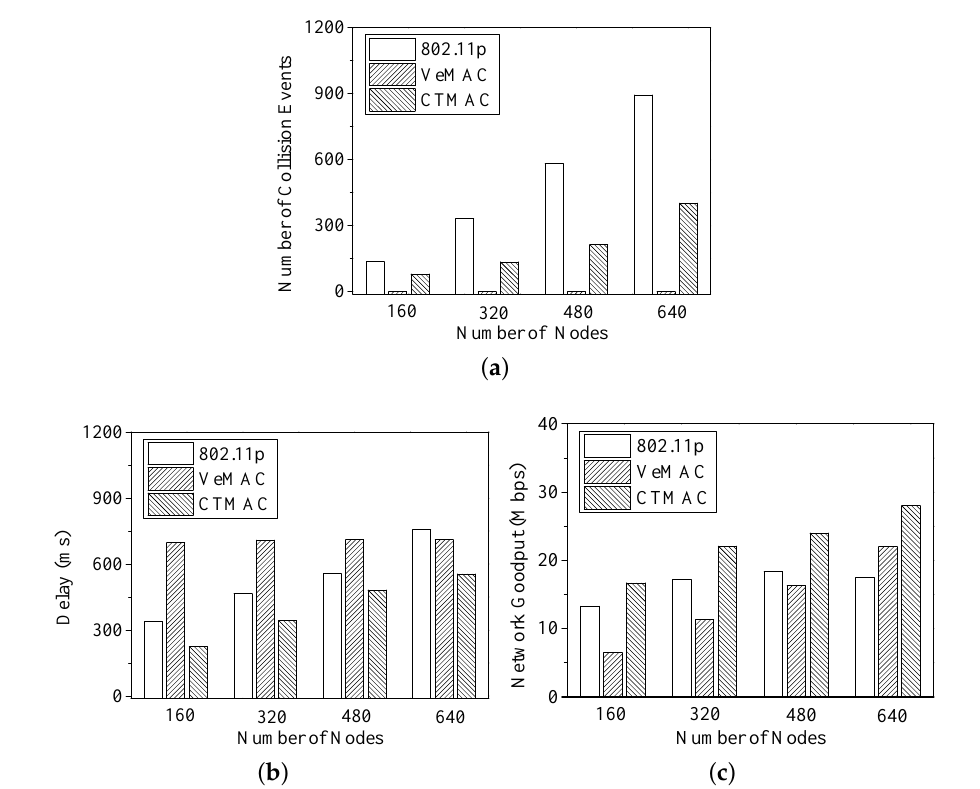
Figure 5. ( a ) Number of collision events; ( b ) delay; and ( c ) network goodput under different vehicle densities.